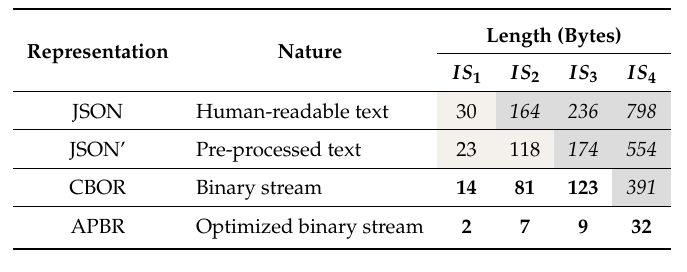
Table 8. Length summaries of four examples of sample instances, as well as their feasibility in the current test-bed implementation.